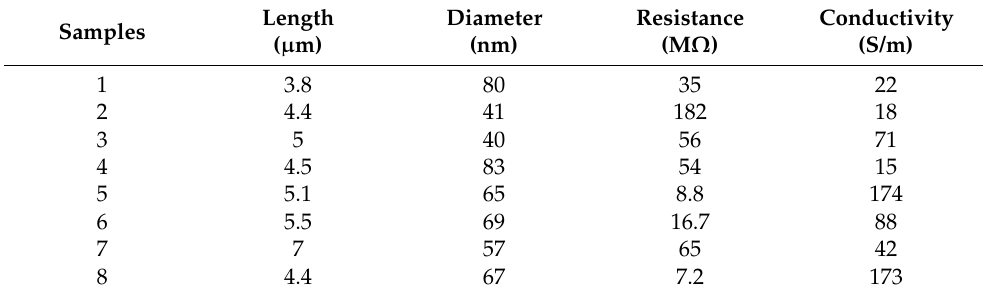
Figure 8. Typical electrical characteristics of an individual In-doped ZnO nanowire, inset is the SEM image during the measurement. Table 1. Geometrical parameters, resistance and conductivity of single In-doped ZnO nanowire prepared using In-Zn film by thermal oxidation